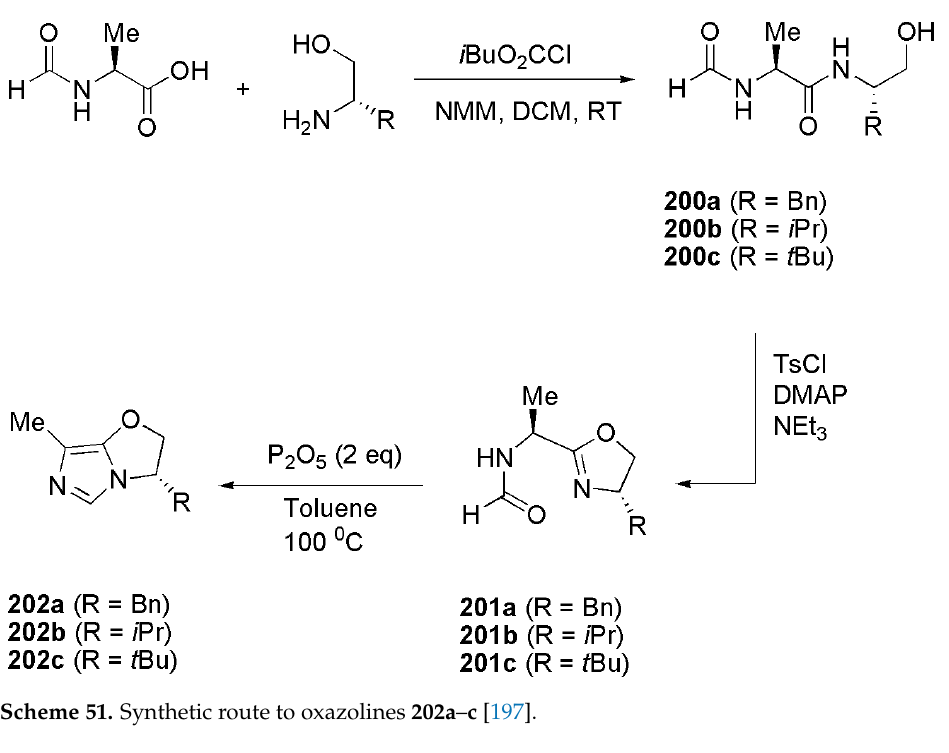
Figure 26. Synthetic route to bicyclic imidazoles [197].